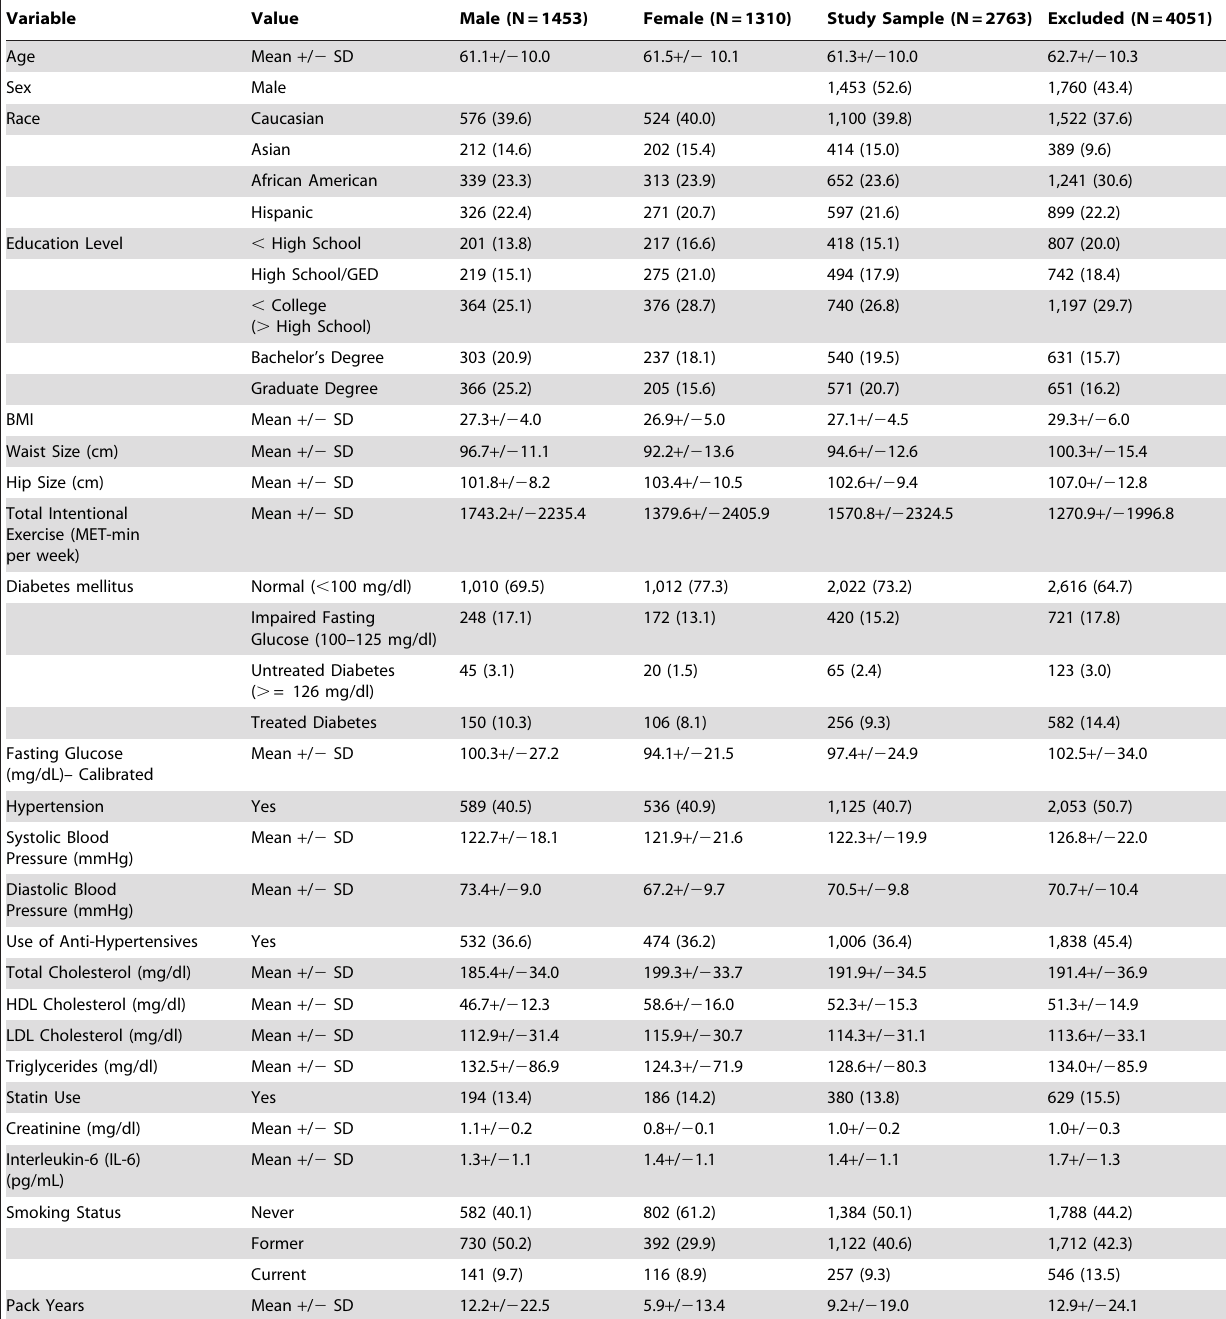
Table 1. Characteristics of study